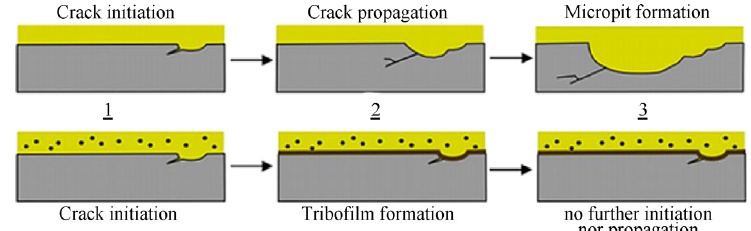
Fig. 9 Lubrication by base oil alone (top), and tribo-film formation and surface protection by NPs (bottom)